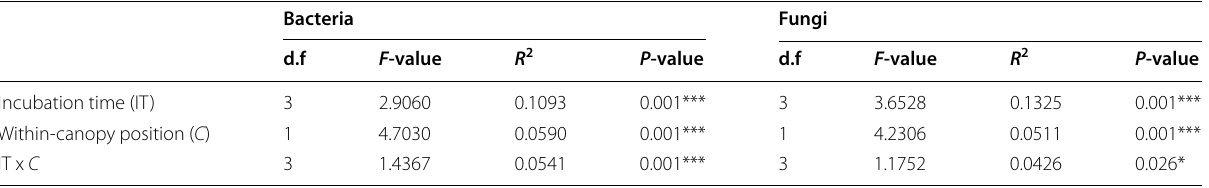
Table 5 Effect of within-canopy initial position of European beech ( Fagus sylvatica ) leaves on microbial community composition during leaf decomposition, tested using permutational analyses of variance (PERMANOVA). Dissimilarities among leaves were estimated using the binary version of Jaccard distance. The incubation time (IT), within-canopy initial position ( C ), and their interaction were tested using sample Set#4 (Fig. 1C) with permutations constrained by tree identity ( T